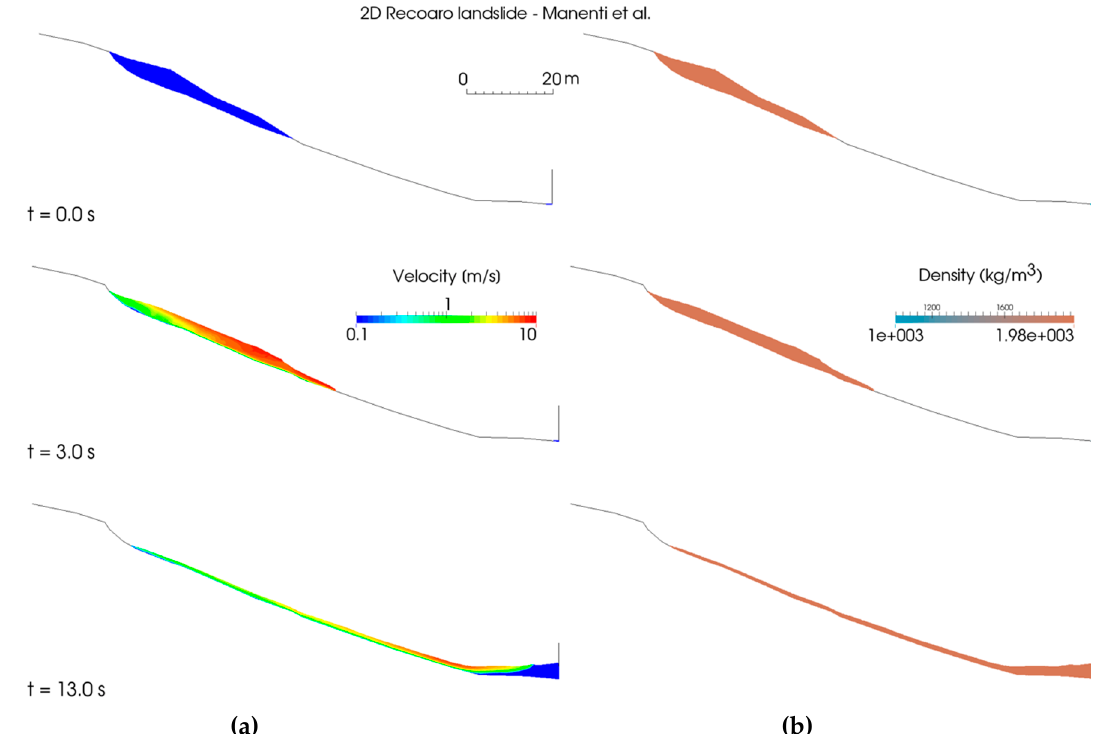
Figure 4. Frames of the 2D smoothed particle hydrodynamics (SPH) simulation of the rainfall induced shallow landslide occurred on April 2009 at Recoaro, Oltrepò Pavese (Northern Italy). ( a ) Velocity field; ( b ) Density field.